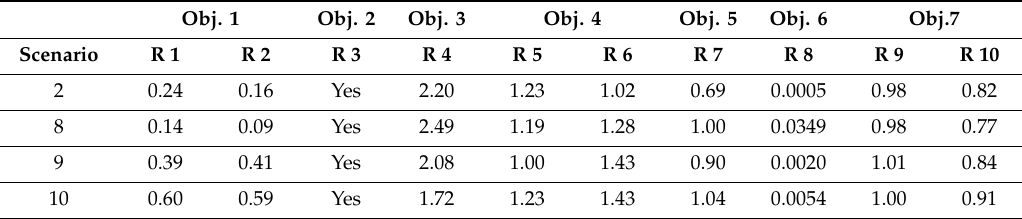
Table 6. Ratios between indicators in Table 5 relative to scenarios 2, 8, 9 and 10, and scenario 1 except for the ratio relative to Id 8 (R 8), calculated as the ratio of Id 8 (volume loss due to competition) and Id 4 (volume